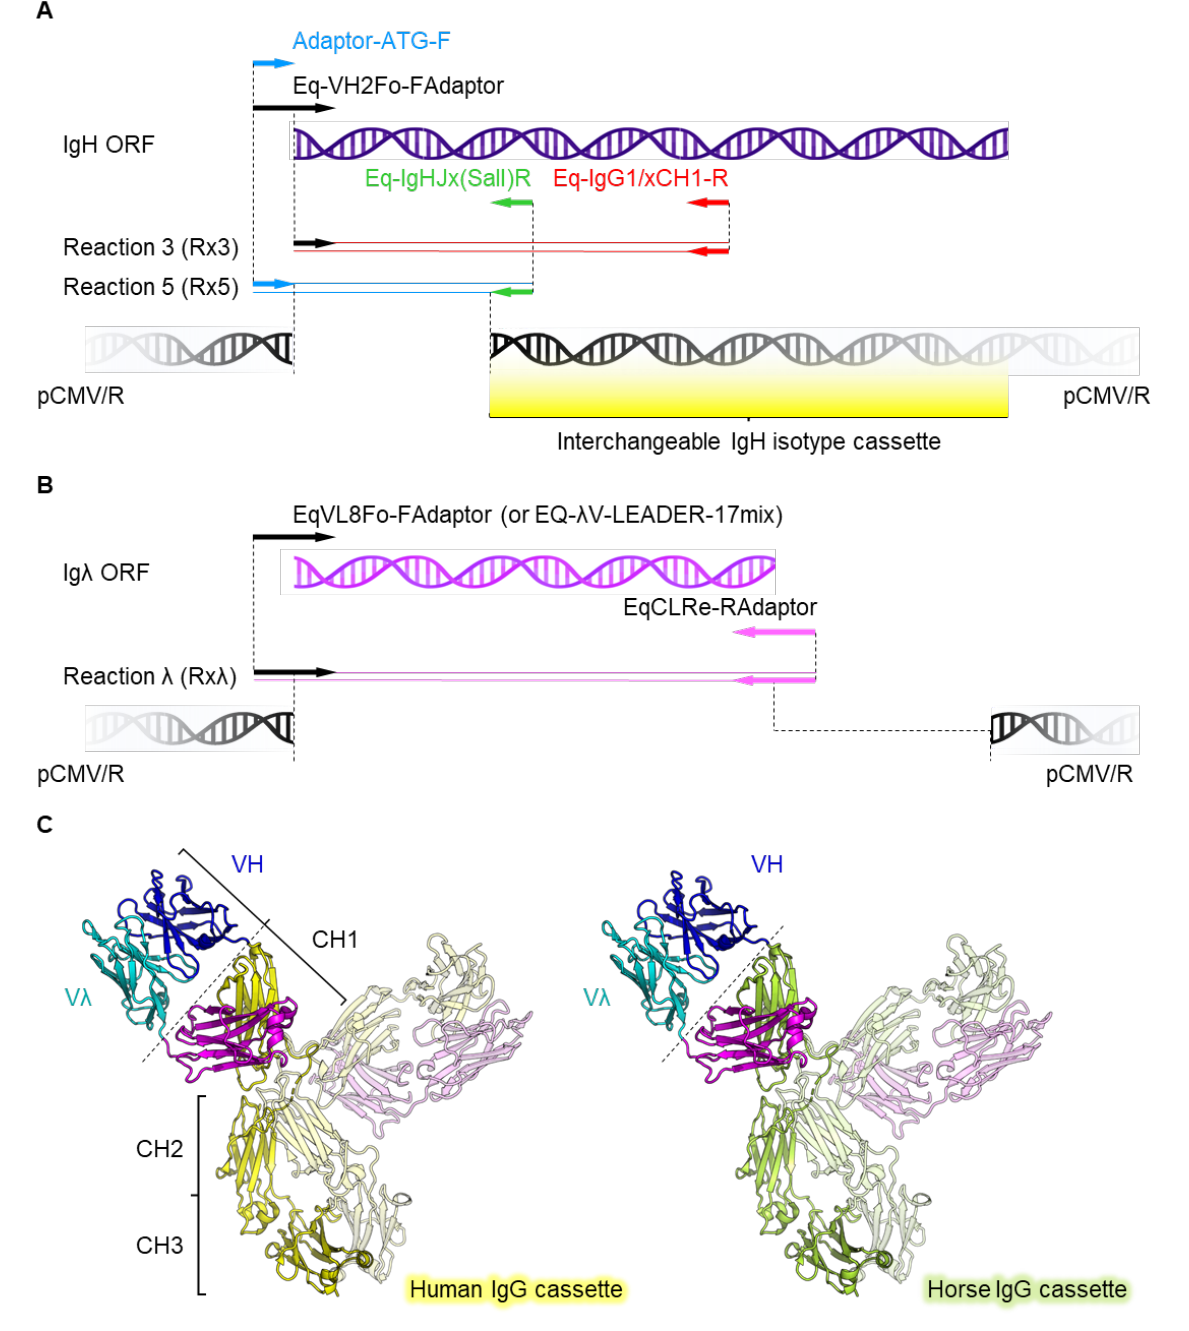
Figure 3. Optimisation of a rapid, isotype exchangeable IgG cloning strategy. ( A ) Schematic of the high-throughput cloning strategy, showing introduction of the adaptor 5′ sequence (cyan), and VH-gene 3′ sequence (green), both of which overlap with cloning sites in the expression vector pCMV/R (black). Gibson assembly using these primer overhangs can be used to clone H V -gene fragments into vectors expressing the constant domains for all known human or horse IgG isotypes. ( B ) Whole λ gene cassettes (pink/purple) were similarly cloned. ( C ) Structural schematic of the horse V -genes cloned into exchangeable human/equine IgG isotype expression cassettes, each with unique effector function capabilities. The VH/V λ domain exists at the end of a flexible hinge region (dotted line), and this exchange does not affect antigen recognition or neutralisation.